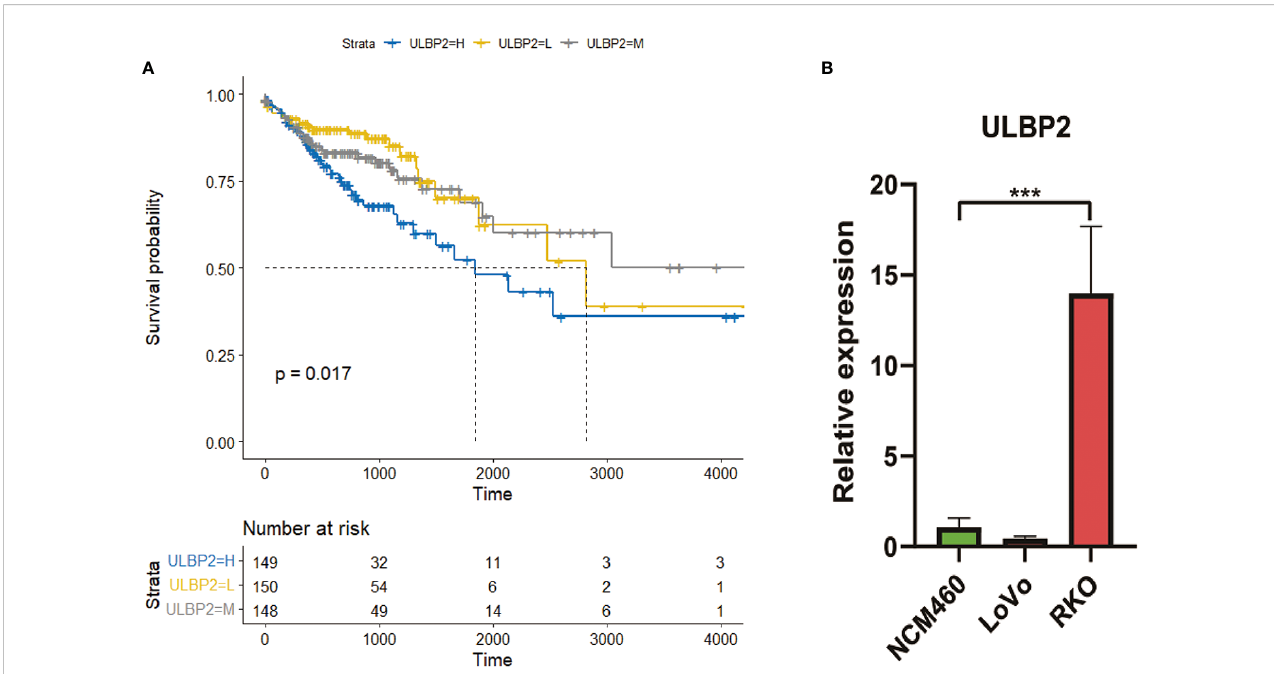
FIGURE 2 The expression and survival analyses of ULBP2. (A) : Survival analysis of ULBP2 among low-, medium-, and high-expression subgroups of ULBP2. (B) : Expression of ULBP2 in normal colon cell lines vs colon cancer cell lines quanti fi ed with